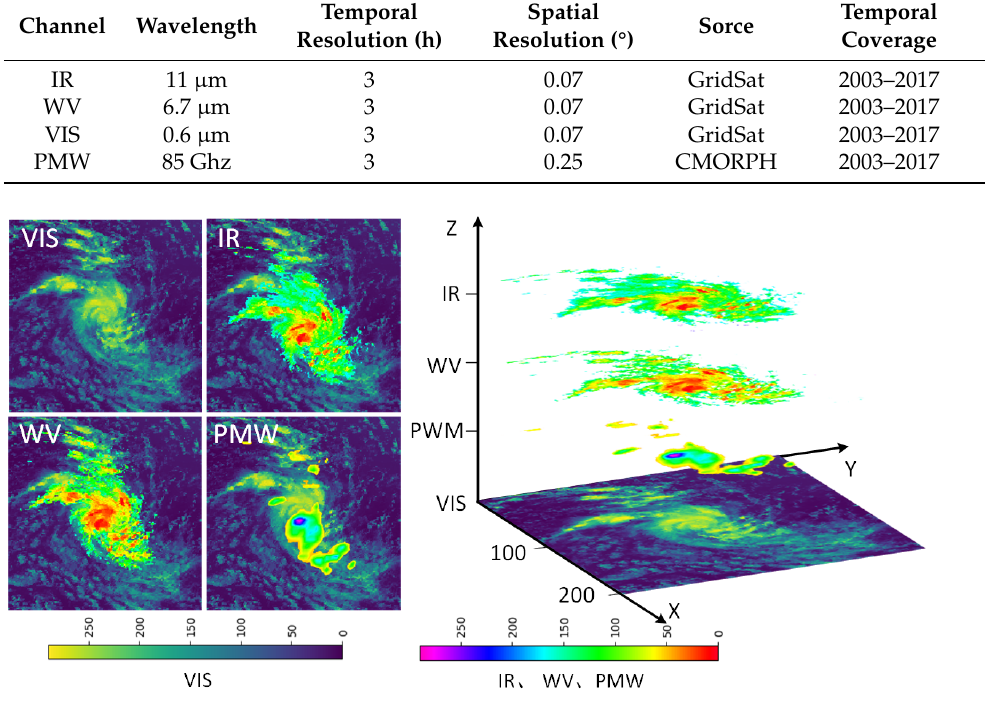
Figure 1. Multi-platform remote sensing data